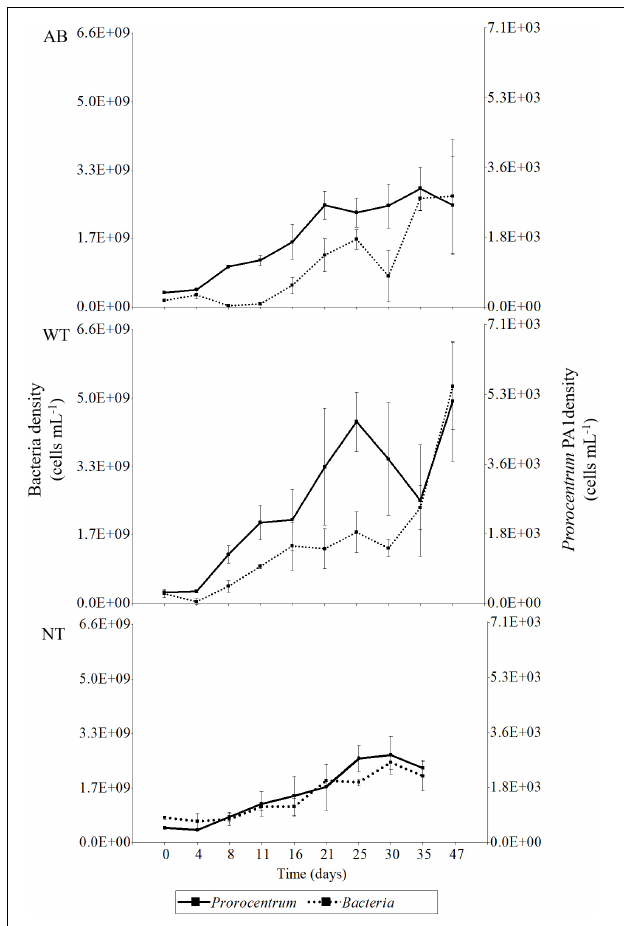
FIGURE 8 | Time-series of bacterial cell density along the growth curve of Prorocentrum PA1 subjected to alternative treatments. AB, washed cells plus antibiotics; WT, washed cells; NT, non-treated cultures. AB, WT, and NT: n = 3 from Day 0 to 35, AB and WT: n = 2 on Day 47. Error bars indicate mean ± standard deviation (SD) of replicate cell